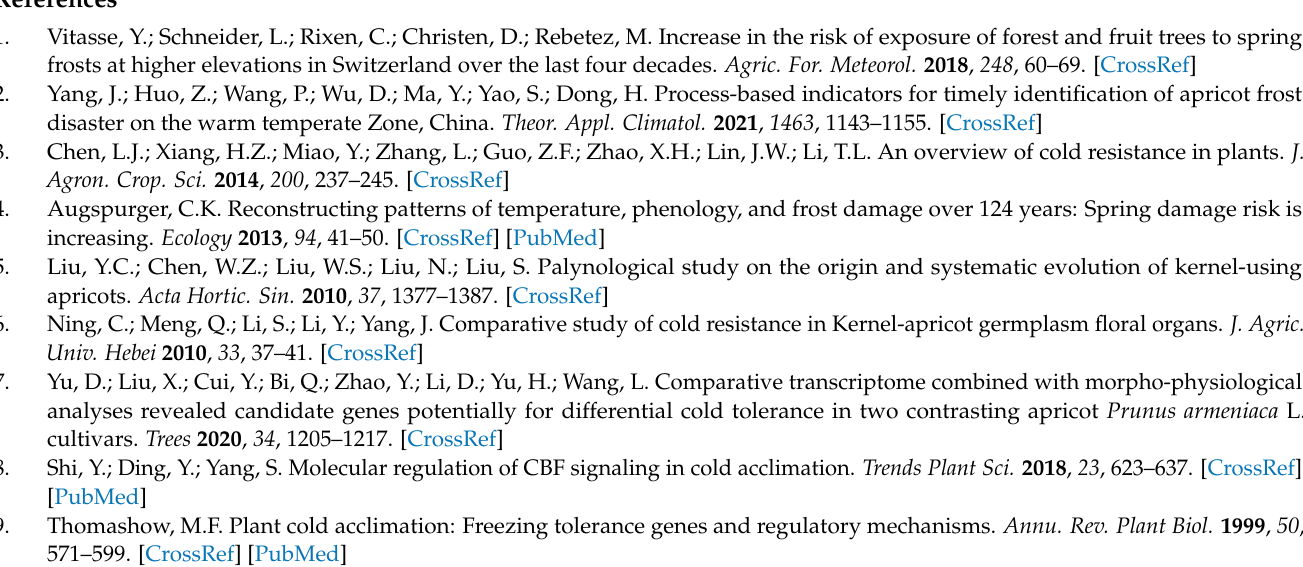
Table S2: The antioxidant enzyme activities in apricot kernel pistils under freezing stress. Table S3: The annotation of hub genes in the magenta